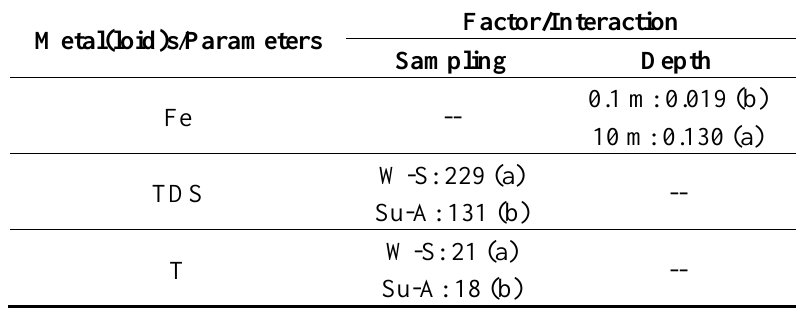
Table A4. Arithmetic means of iron concentrations, total dissolved solids and temperatures with probability values from factors and theirs interaction with significant differences ( MANOVA, p < 0.05) in water sampled from two depth at Luis L. Leon reservoir.